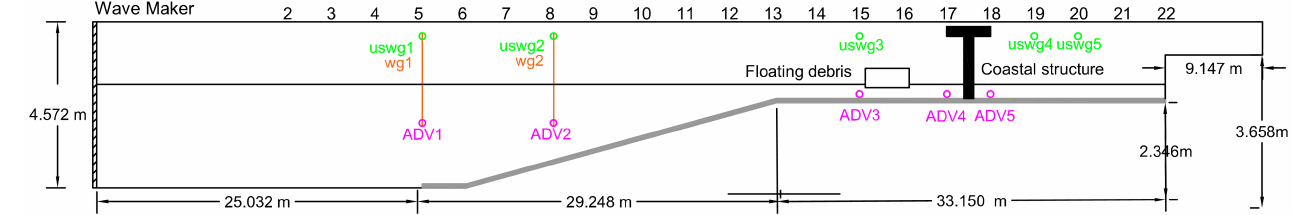
Figure 1. Cross-section of the Large Wave Flume (LWF) depicting the bathymetry, column location and flume instrumenta- tion of the experiments of Ko and Cox [65] used for the validation